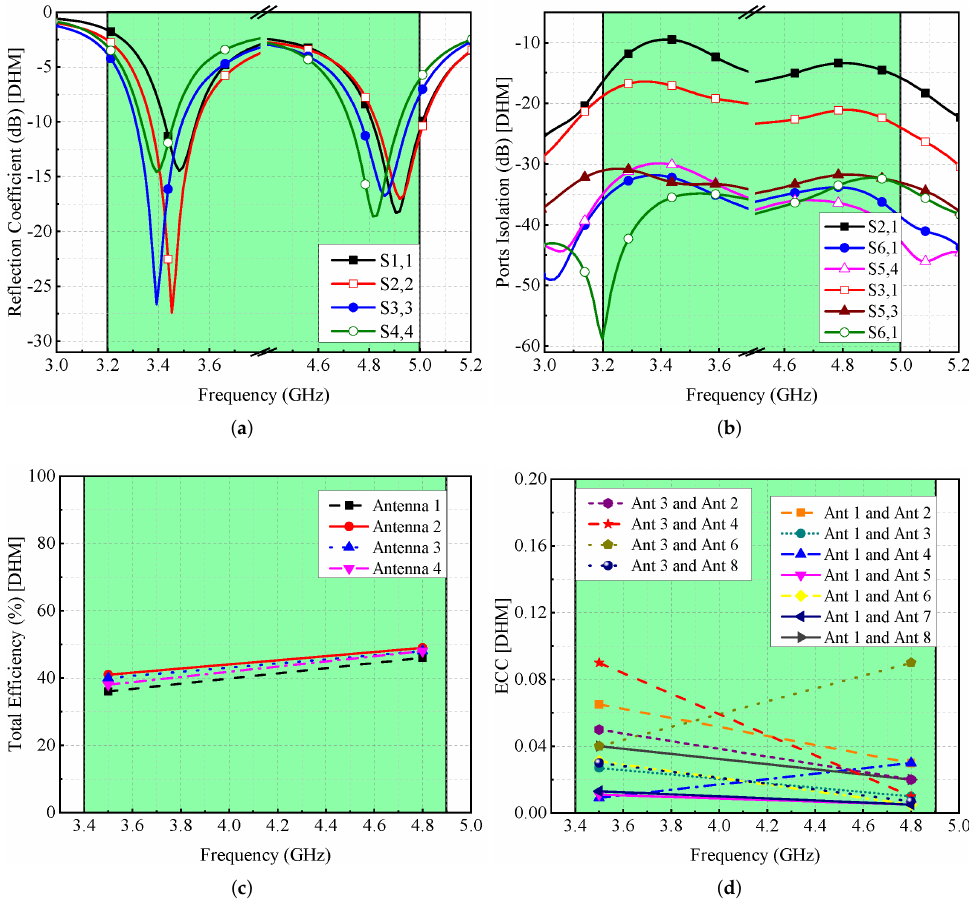
Figure 15. Effect of double-hand on MIMO antenna’s ( a ) reflection coefficient, ( b ) isolation, ( c ) efficiency, and ( d ) ECC. Table 2. Comparative analysis among previously presented and proposed MIMO